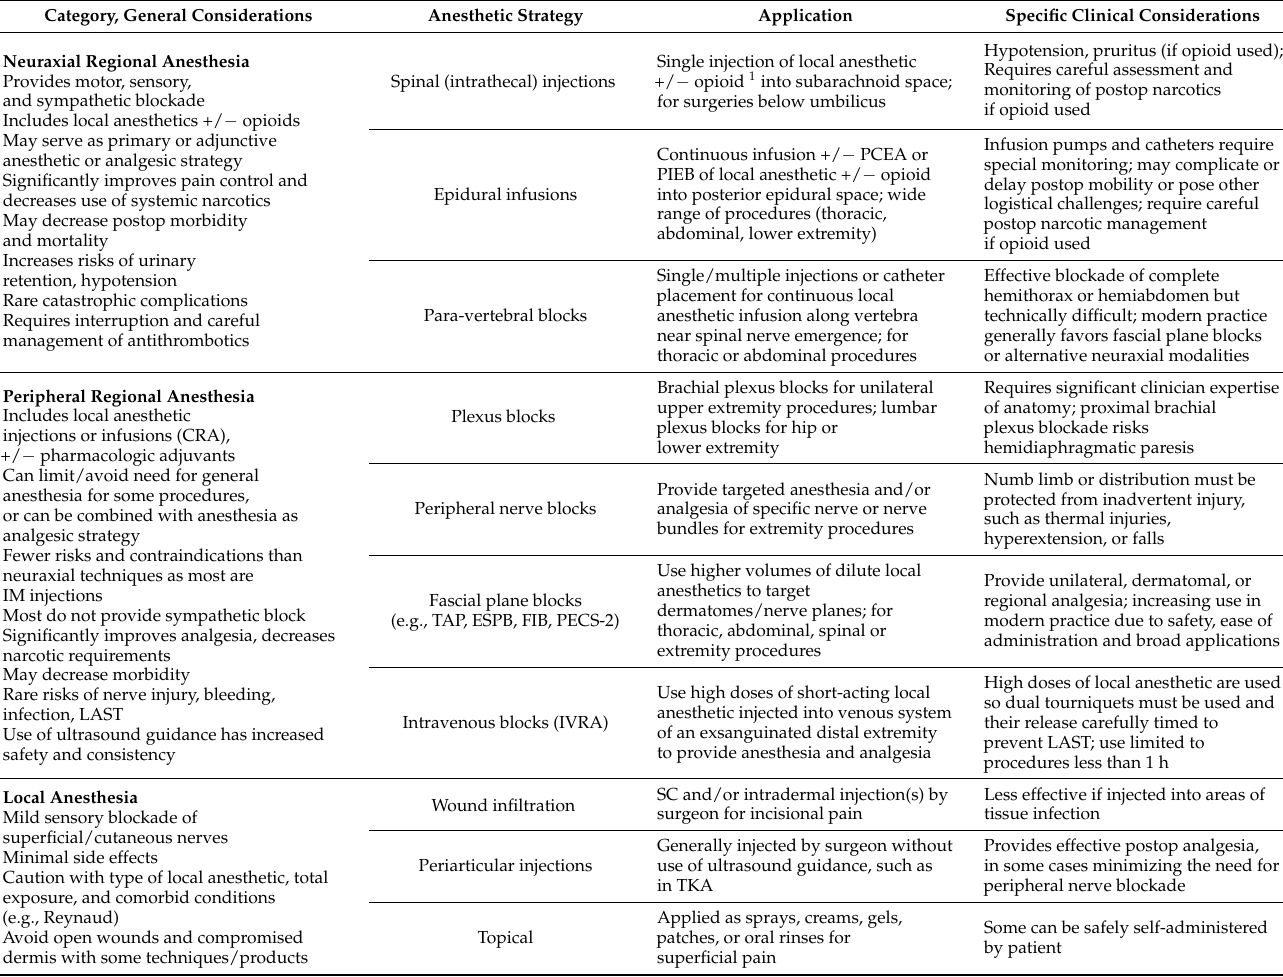
Table 5. Selected Attributes of Regional and Local Anesthetic Strategies for Pain Management and/or Opioid Stewardship. Category, General